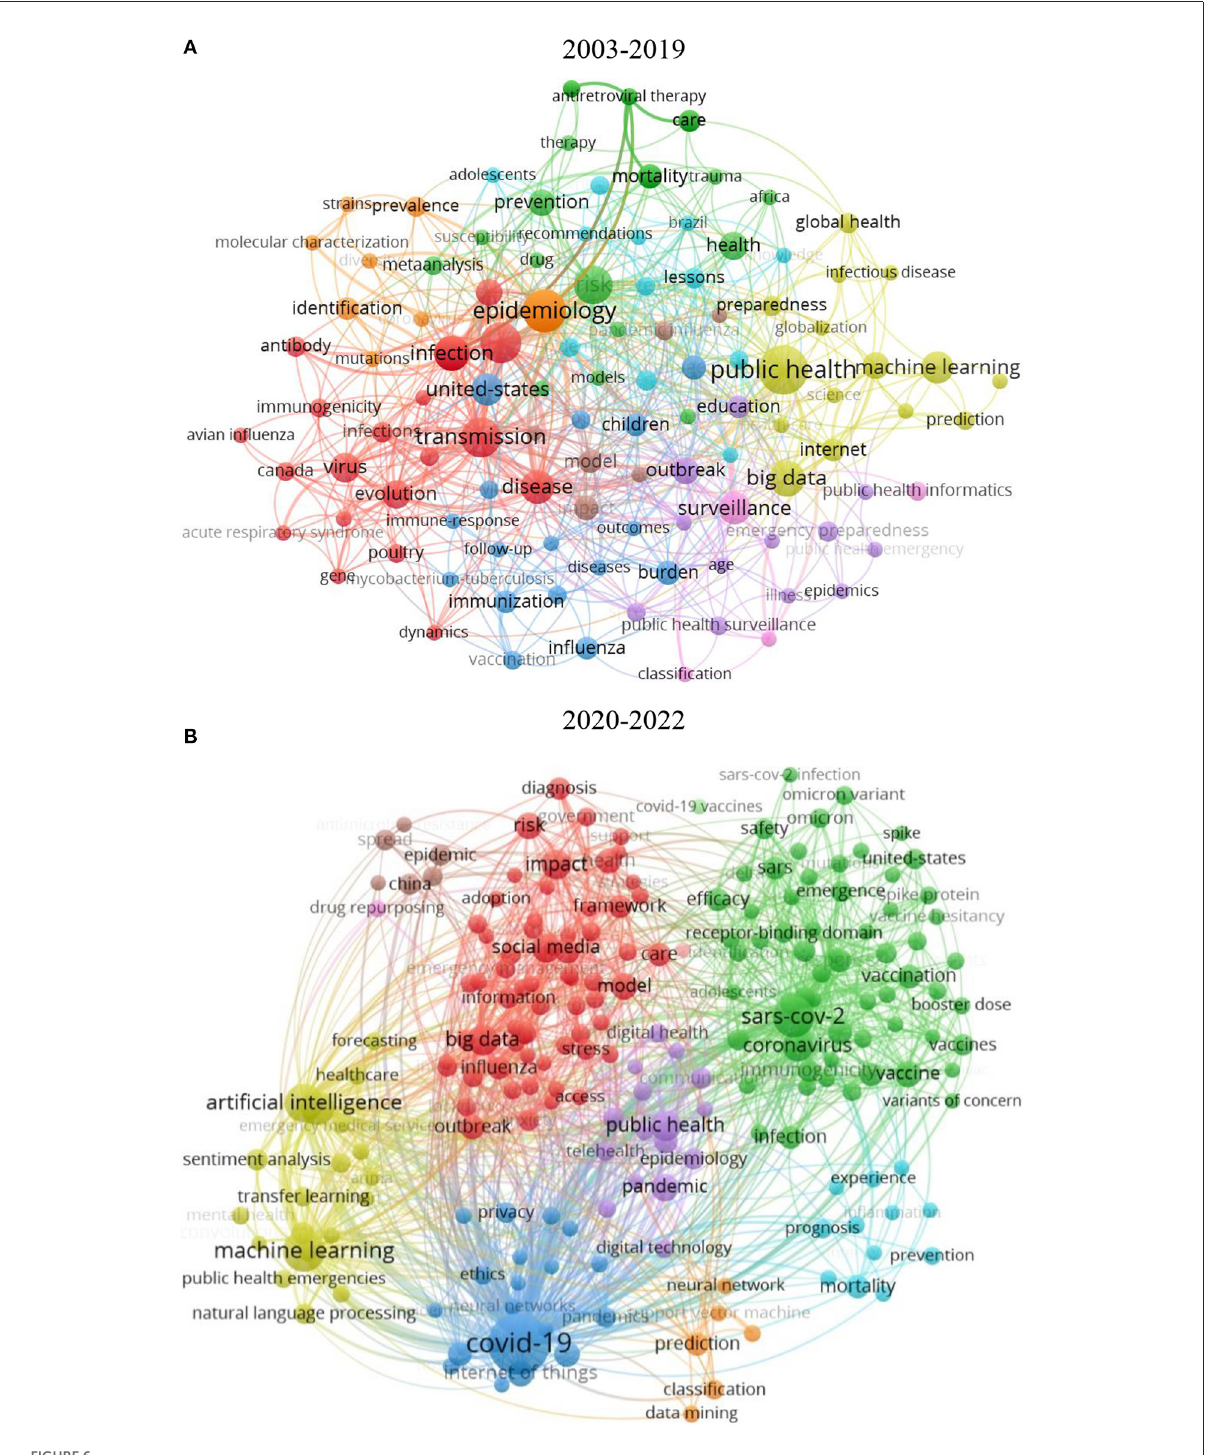
FIGURE6 (A) Mapping knowledge domains of the keywords plus co-occurrence network from 2003 to 2019. (B) The keywords plus co-occurrence network from 2020 to